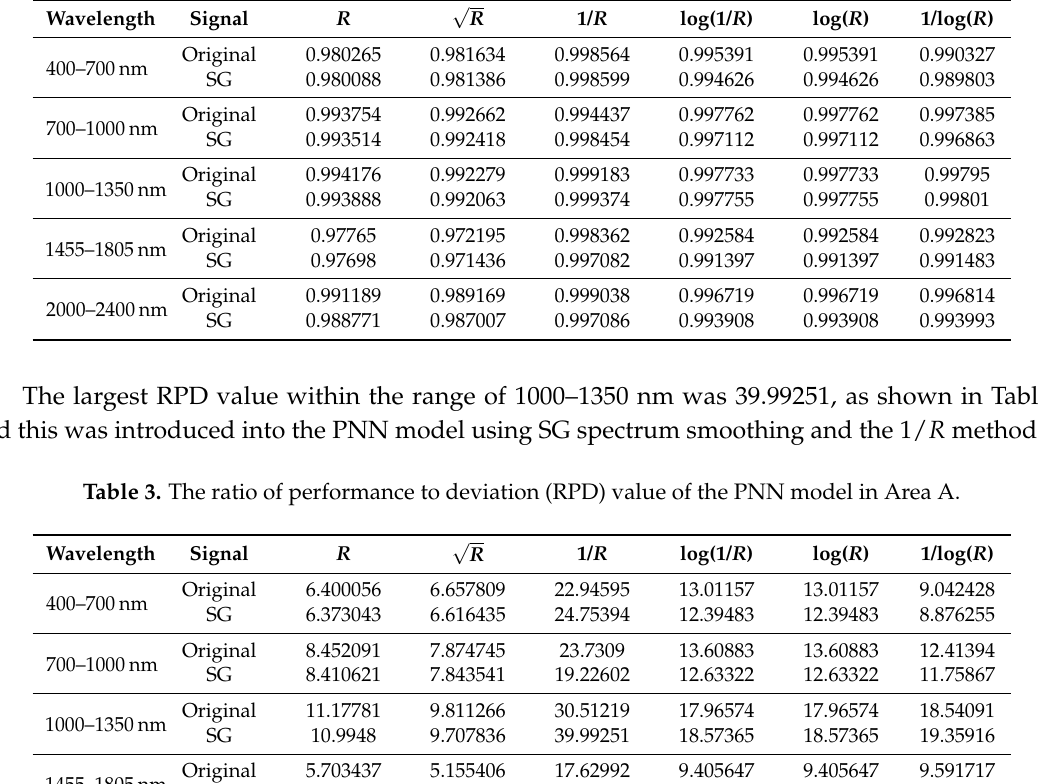
Table 2. The R 2 value of the PNN model in Area A.